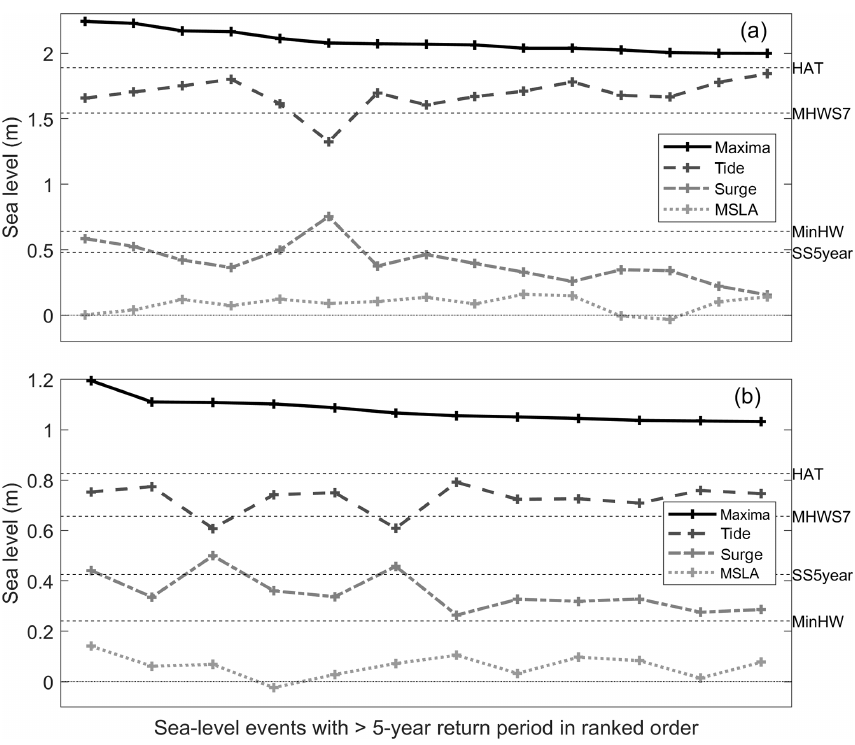
Figure 3. The contributions of tide, skew surge and MSLA to the ≥ 1 in 5-year return period extreme storm-tide maxima at two of NZ’s longest sea-level recorders with a meso-tidal ( a Auckland) and micro-tidal ( b Wellington) range. HAT denotes the highest astronomical tide, MHWS-7 is the height equalled or exceeded by the highest 7% of all high tides, MinHW denotes lowest high tide height; SS5year is the height of the 1 in 5-year return period skew